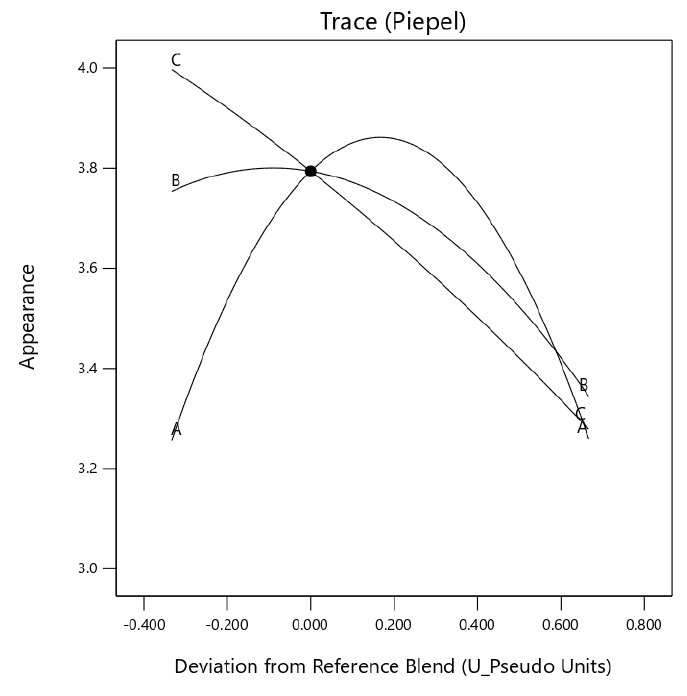
Figure 2. Trace (Piepel) plot for the effect of three components on appearance (A: boiled egusi grit, B: flour and C: hydrocolloid) on instant egusi soup.